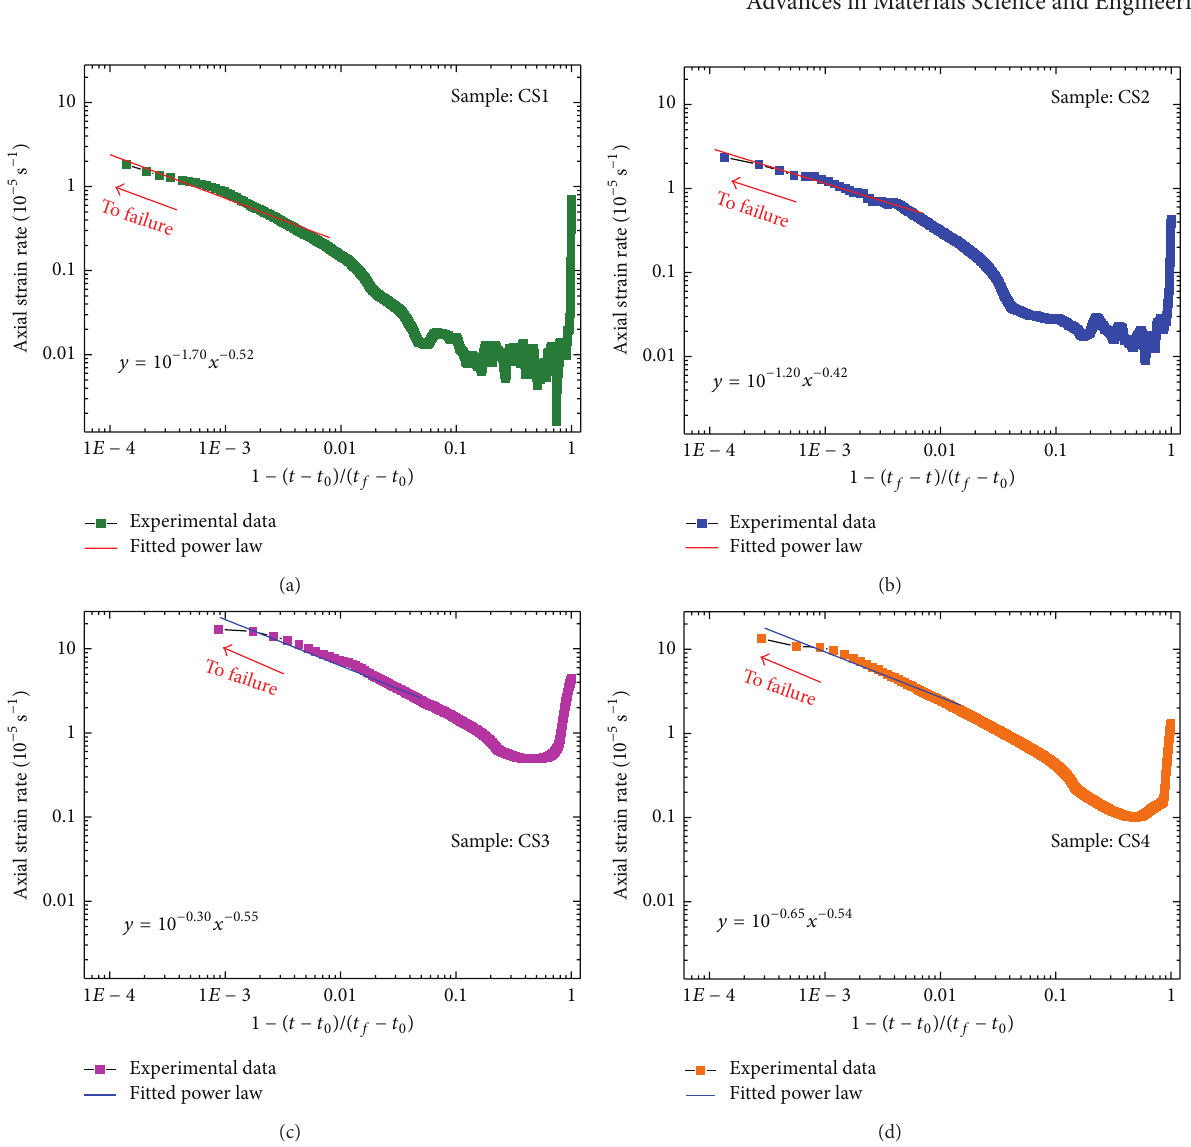
Figure 8: Log-log plots of axial strain rate against time for four specimens. The power-law fits (see the solid red lines in (a) and (b), and the solid blue lines in (c) and (d)) to the experimental data near failure are indicated in the figures. The power-law exponent is equal to −0.51±0.06 and it is approximately equal to the theoretical value of − 1/2 quoted in